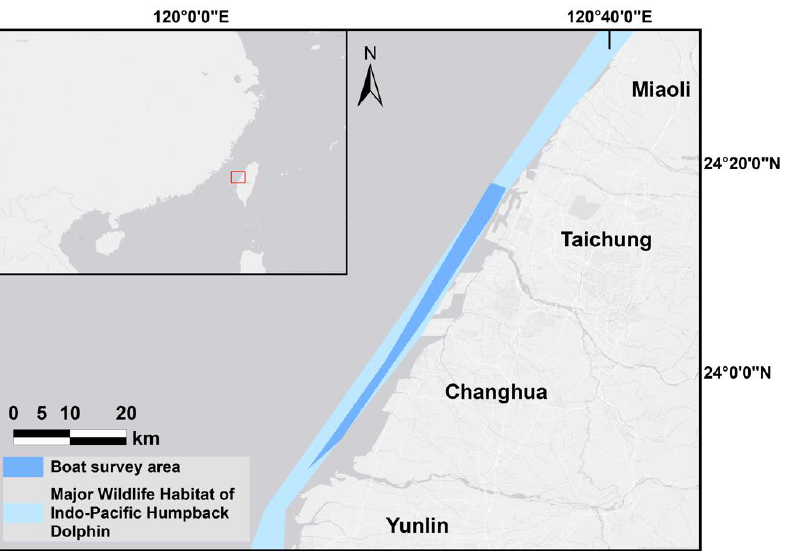
Figure 1. The major wildlife habitat of the Indo-Pacific humpback dolphin and the boat survey area along the west coast of central Taiwan.